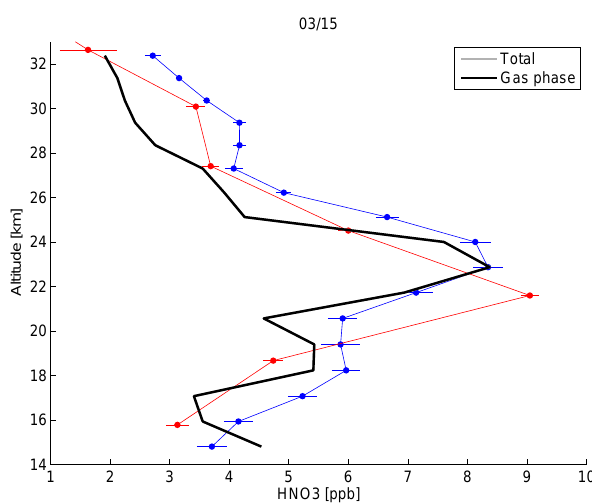
Fig. 7. HNO 3 profile from the OMS balloon launch on 15 March 2000 measured by the Mark IV instrument (blue) and the SLS in- strument (red). The black line shows the modeled profile. Note that Mark IV and SLS are remote sensing instruments viewing into opposite directions and that the mixing ratios of the species are in- terpolated to the Mark IV tangent